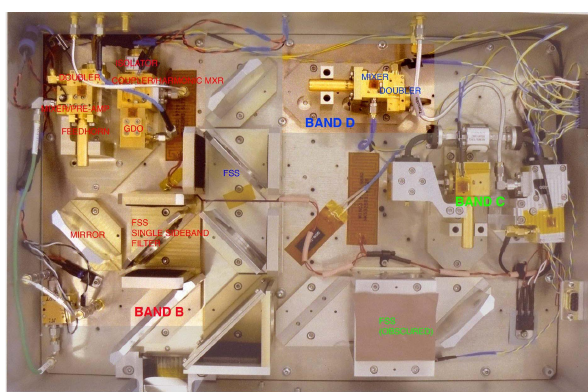
Fig. 1. Constellation of the MARSCHALS receivers and sideband filters after the UAMS instrument upgrades. The atmospheric signal enters the quasioptical subsystem at the bottom of the picture. The band D signal is separated by a polariser, the band B and C signals are separated by a beam splitter.